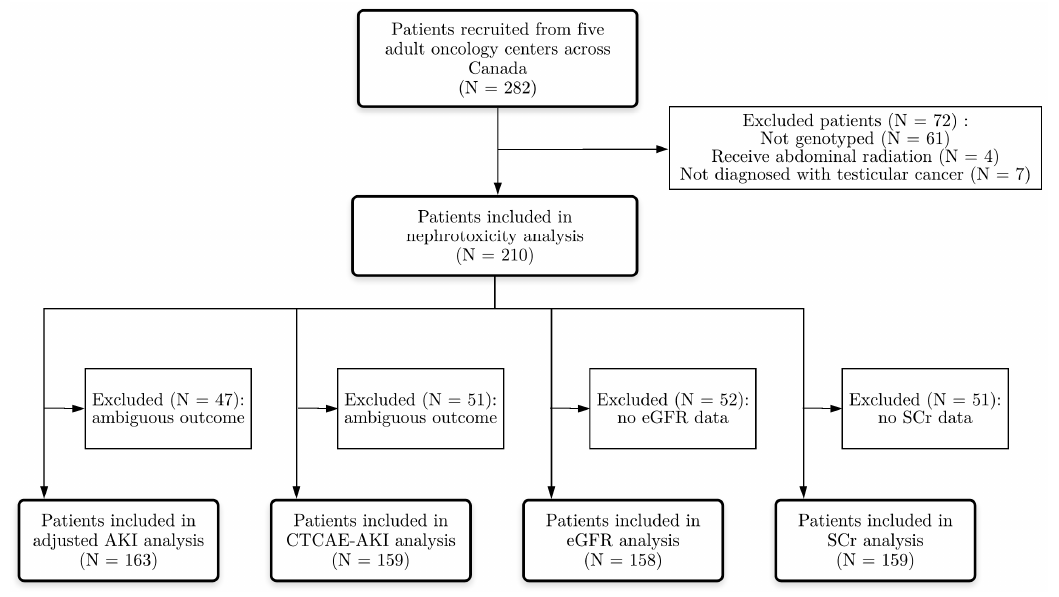
Figure 1. Flowchart of patient inclusion in statistical analyses. Table 4. Clinical characteristics testicular cancer patients included in nephrotoxicity analyses (N = 210).